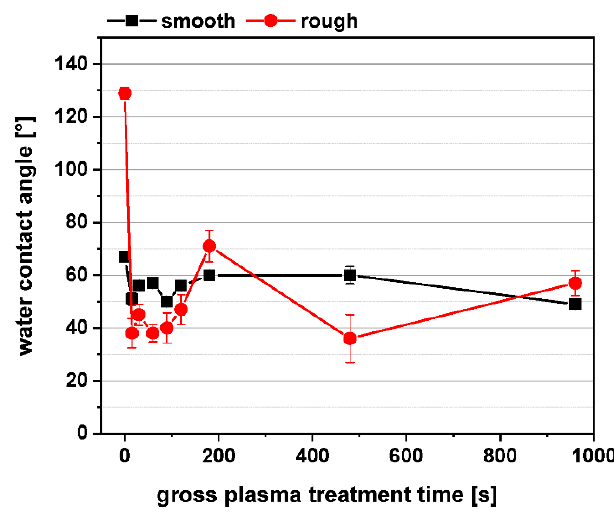
Figure 6. Water contact angles of untreated (time point 0 s) and PPAAm-coated smooth and rough ceramic. Note: Even a very short plasma treatment time of 15 s is sufficient to shift the water contact angles (WCA) of the untreated samples into the hydrophilic region. (Plasma treatment times: 15, 30, 60, 90, 120, 180, 480, and 960 s; n = 5).